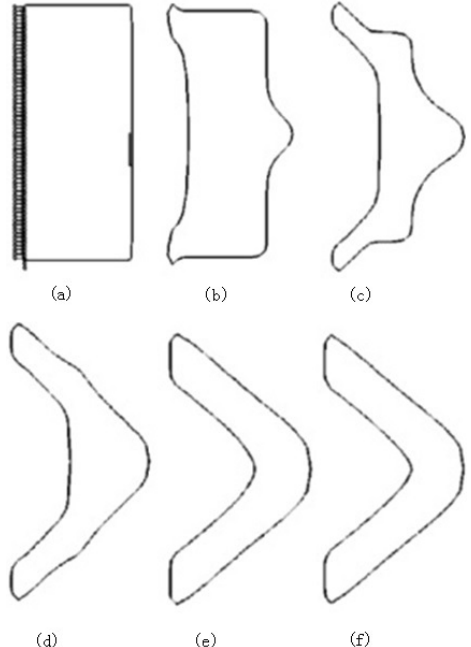
Figure 1. Topological optimization process using the level set method: (a) original fixed model with constraints; (b–e) interme- diate optimization process for topology optimization; (f) final opti- mization of the structure shape (Wang et al.,